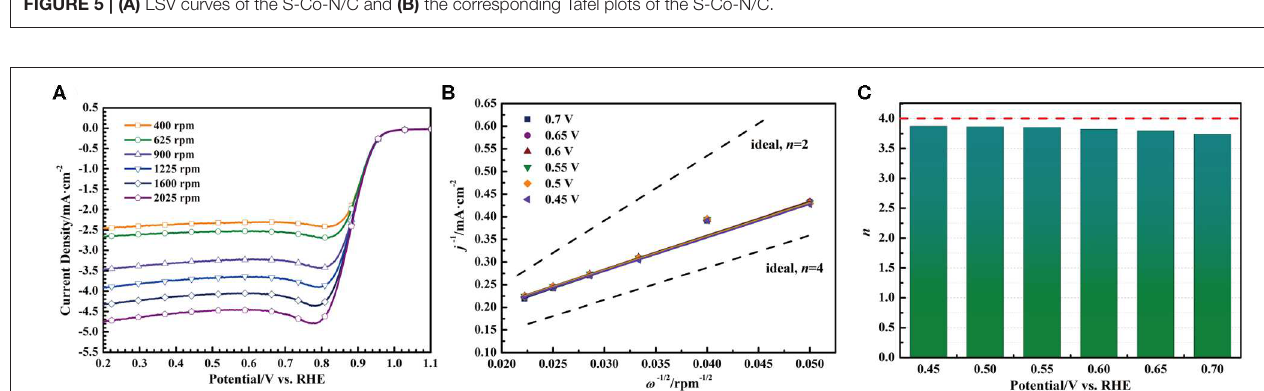
FIGURE 5 | (A) LSV curves of the S-Co-N/C and (B) the corresponding Tafel plots of the S-Co-N/C.